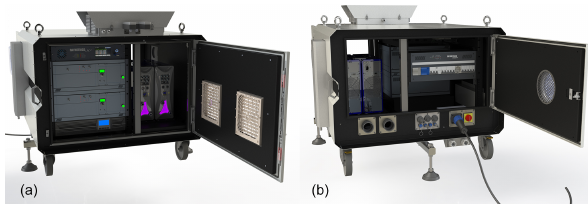
Figure 4. The front (a) and back (b) view of the electronics enclo-